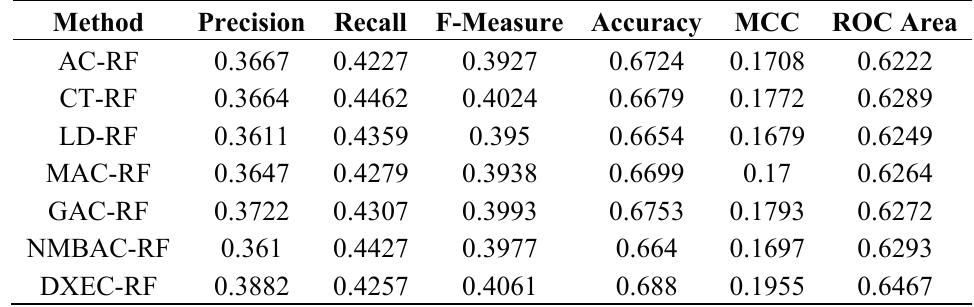
Table 2. Performance comparison of seven methods on the Yeast All dataset by using the Silver Yeast